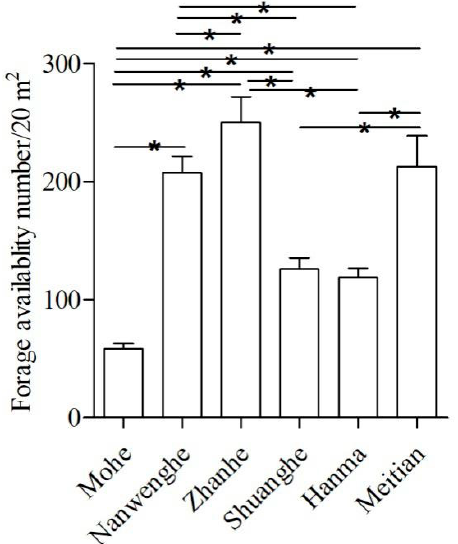
Figure 2. Forage availability expressed as the number of annual new shoots in the survey plots (10 m × 10 m) in Mohe, Nanwenghe, Zhanhe, Shuanghe, Hanma, and Meitian. Except for among Meitian, Nanwenghe, and Zhanhe, as well as between Shuanghe and Hanma, there were significant differences between sites. Asterisks indicate significant differences (F = 15.64, p < 0.05).